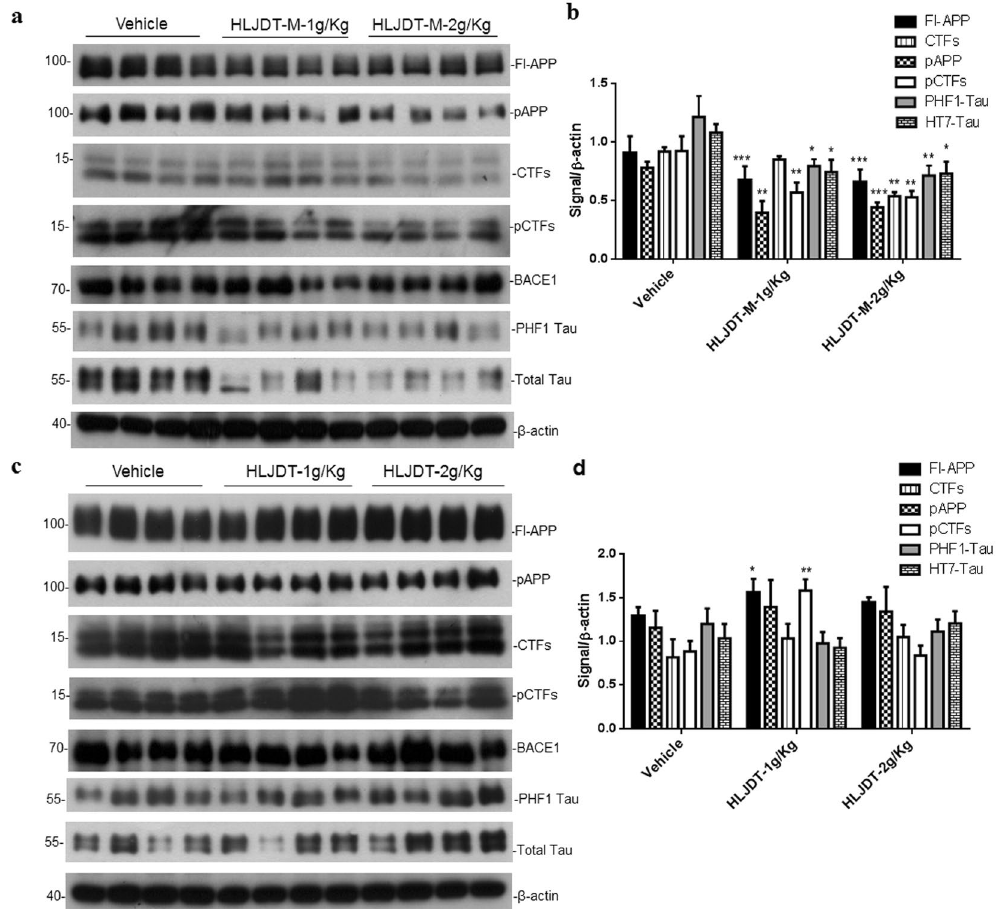
Figure 5. Different treatment effects of HLJDT-M ( a ) and HLJDT ( a ) on the levels of APP metabolites, phospho-Tau and total Tau in 3XTg-AD mice. Immunoblot presenting the levels of FL-APP, CTFs (CTF α and CTF β ), pAPP and pCTFs ( α and β ). Quantification of immunoblots by densitometric analysis and is presented as the ratio of FL-APP, CTFs, pAPP, PHF-1 Tau, total Tau and pCTFs against β -actin in the SDS brain lysates of 3XTgAD mice treated with HLJDT-M or HLJDT or vehicle ( c and d ). The statistical significance are denoted as * p < 0.05, ** p < 0.01, ** p < 0.001 when compared with vehicle-treated 3XTg-AD mice. Data represent mean ± SEM. N = 8 mice per